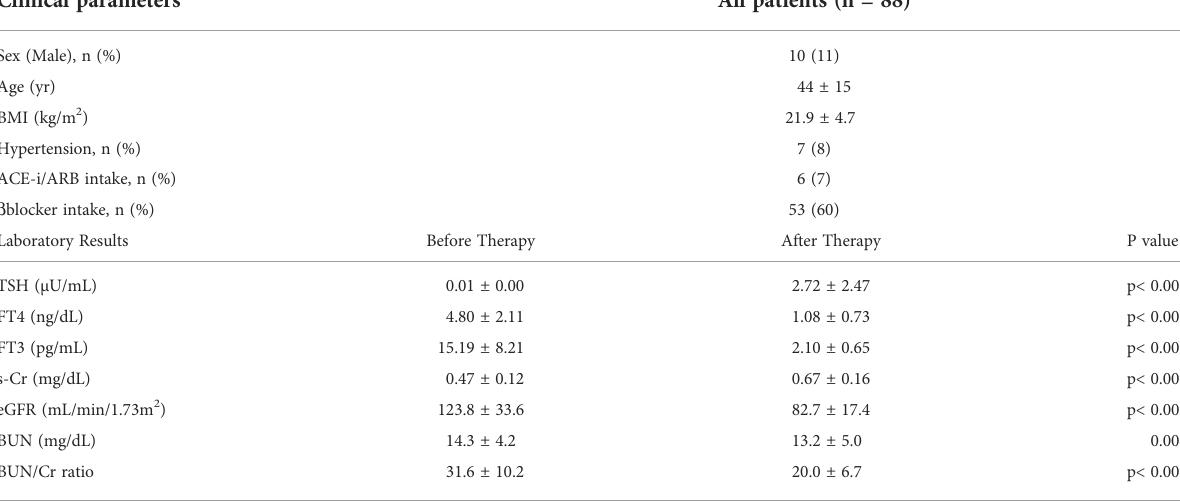
TABLE 1 Clinical characteristics before and after treatment in hyperthyroidism. Clinical parameters